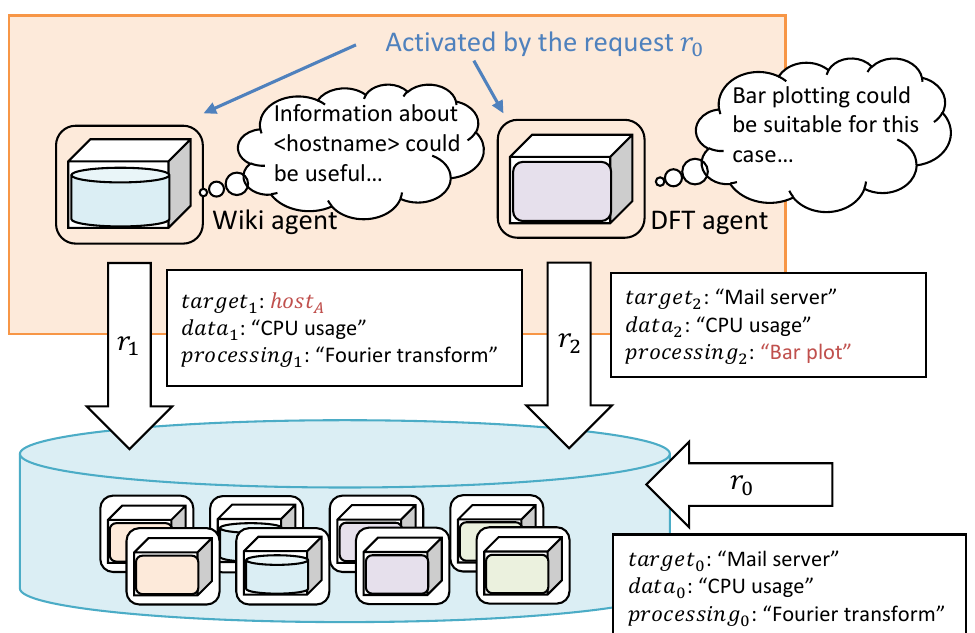
Figure 2. Example of request expansion. The activated DPAs can generate secondary requests, partially replaced by knowledge of the semantic relation. The mechanism provides a bottom-up expansion of demands in the request.